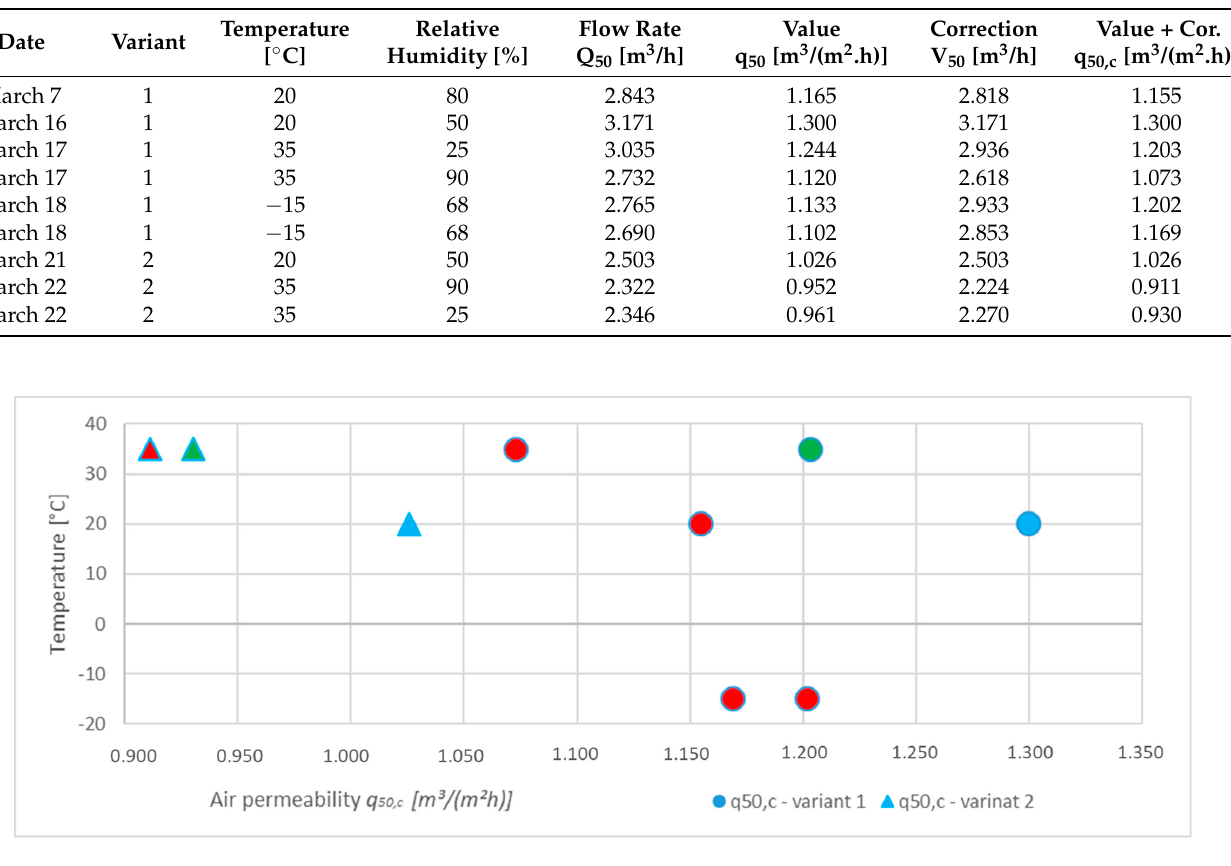
Figure 18. Results of the air permeability in histogram form.